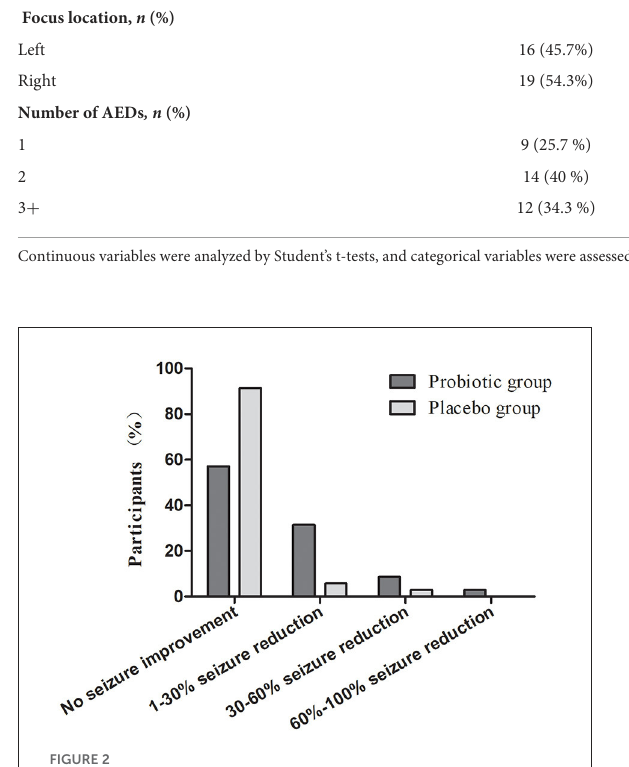
the probiotic and placebo groups on AMI, VWMI, VMI, IMI, and